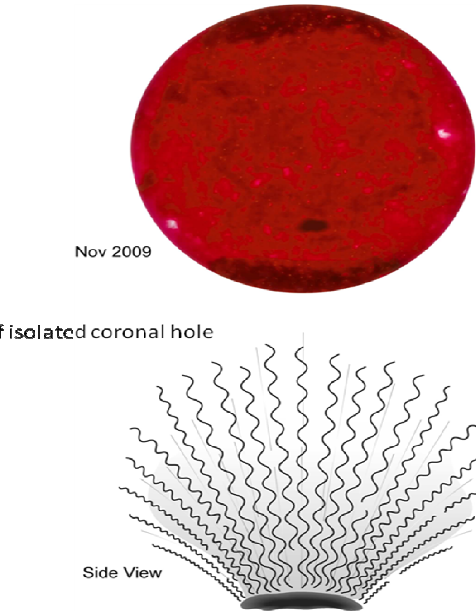
Figure 9 Fig. 9. The top panel shows an artist’s schematic of the midlatitude coronal hole and polar coronal holes in Fig. 8. The bottom panel shows a blowup (and side view) of the midlatitude coronal hole, the solar wind velocity emanating from the hole and the Alfv´en fluctu- ations carried by the solar wind. The solar wind speed is highest ( ∼ 750 to 800kms − 1 ) over the center of the hole. The Alfv´en wave amplitudes are the largest there. Because of superradial expansion, the solar wind speed and Alfv´en wave amplitudes are diminished at the edges of the